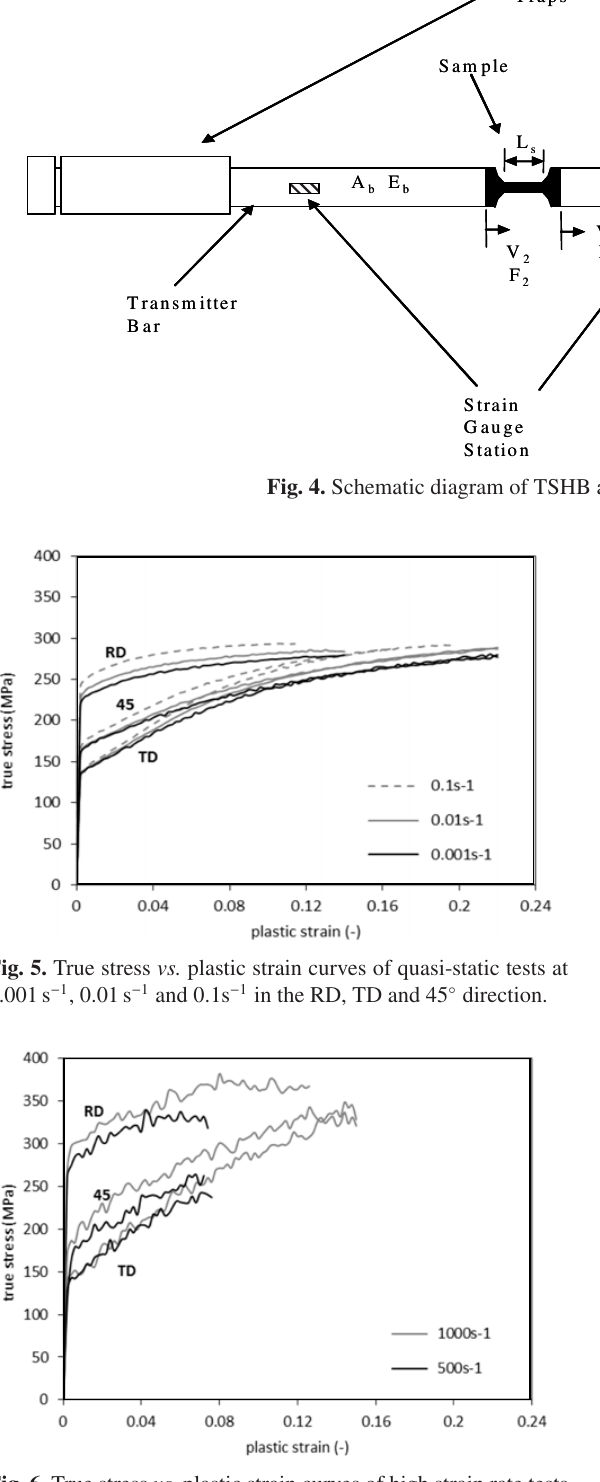
Fig. 6. True stress vs. plastic strain curves of high strain rate tests at 500s − 1 and 1000 s − 1 in the RD, TD and 45 ◦ direction.